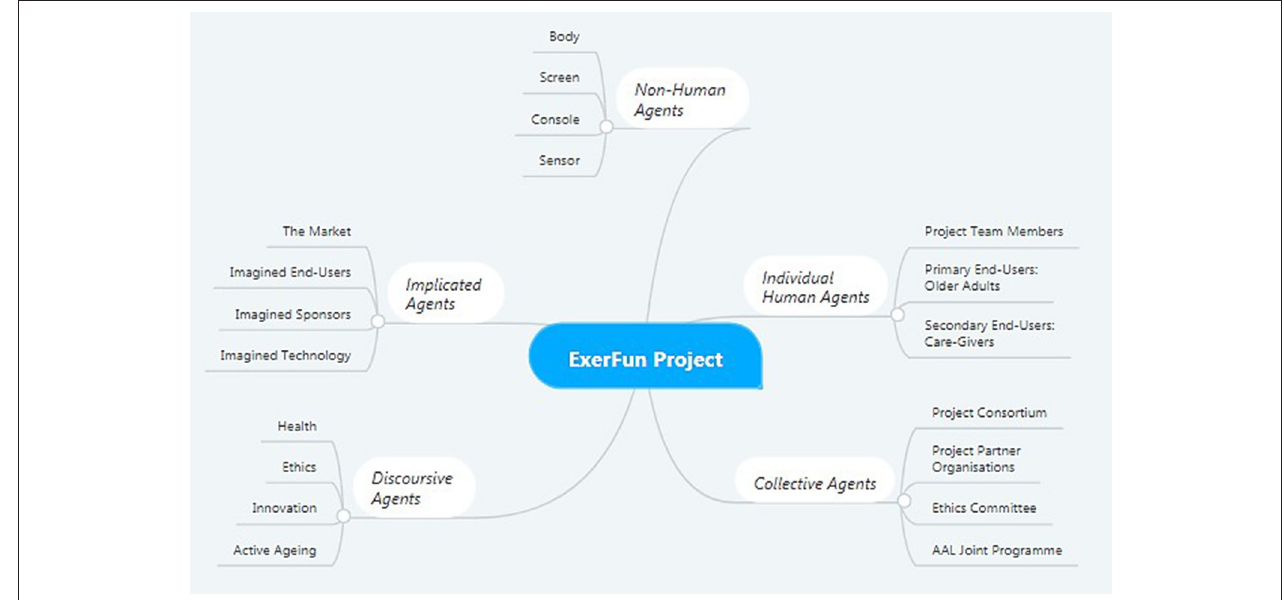
FIGURE 2 | Agents in the ExerFun